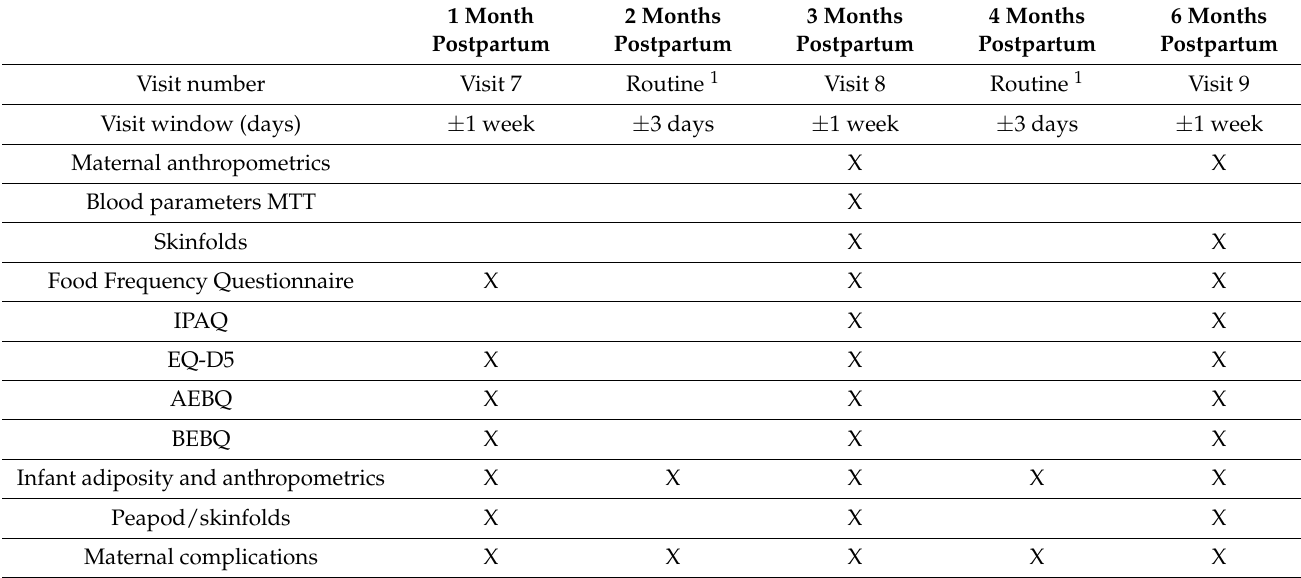
Table 2. Timing of data collection up to 6 months